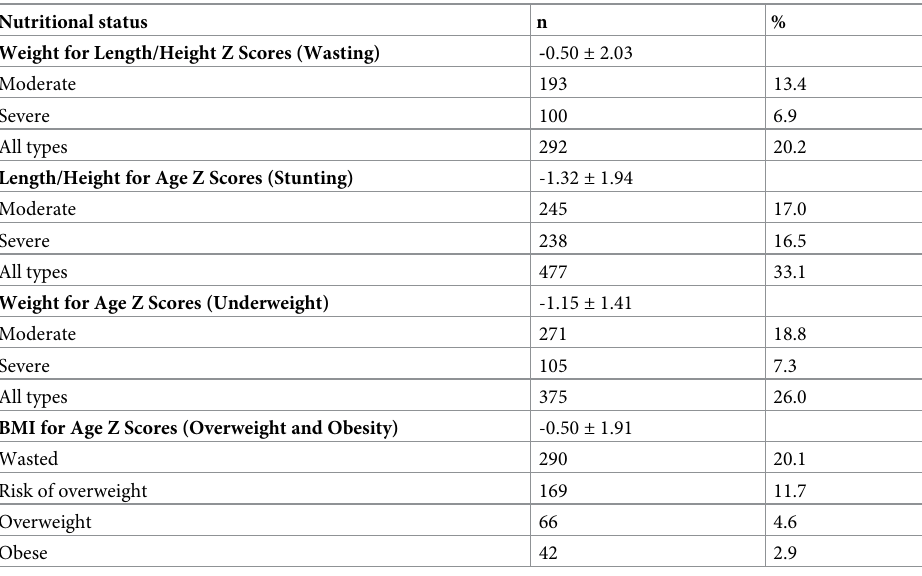
Table 4. Distribution of nutritional indicators among